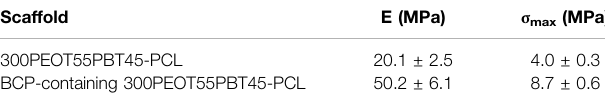
TABLE 1 | Compressive mechanical properties of 3DF scaffolds based on PEOT/ PBT polymeric pastes: compressive modulus (E) and maximum stress ( σ max ) reported as mean value ± standard deviation for structures fabricated with 300PEOT55PBT45-PCL and BCP-containing 300PEOT55PBT45-PCL pastes. Scaffold